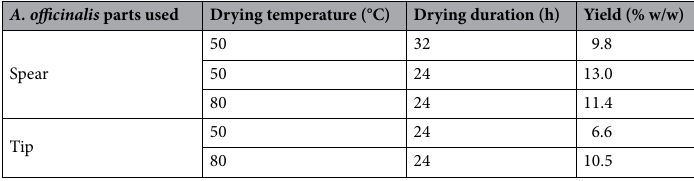
Table 1. A. officinalis extracts and their raw materials.